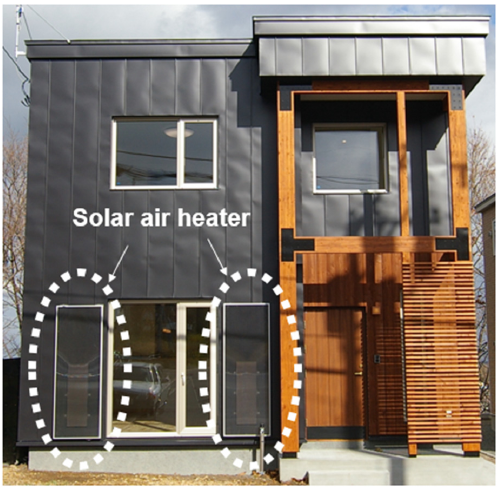
Figure 5. Facade of the house with the solar air heater on external wall. Table 3. Outline of a house. Item Detail Location Sapporo City, Hokkaido Completion